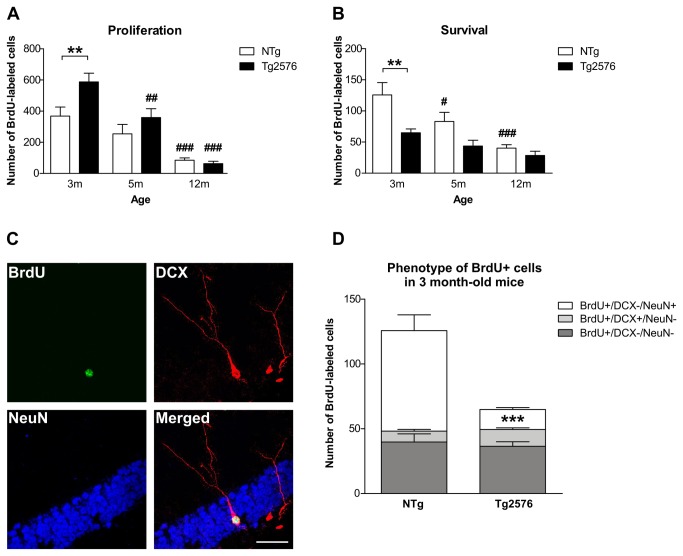
Altered adult hippocampal neurogenesis in 3 month-old Tg2576 mice.(A) New cell proliferation was measured in the dentate gyrus of NTg and Tg2576 mice at different ages (n=8-11 mice/group). Mice from both genotypes exhibit overall decreased numbers of BrdU-labeled (BrdU+) cells in the dentate gyrus along aging, reflecting age-related reduction in cell proliferation. At 3 months, Tg2576 display enhanced proliferative activity compared to age-matched NTg mice. (B) BrdU was injected in 3 month-old mice and numbers of surviving BrdU+ cells were evaluated 30 days after (n=7-9 mice/group). These numbers decreased with age in both genotypes. Moreover, the number surviving BrdU+ cell was drastically reduced in Tg2576 mice injected at 3 months of age compared to age-matched NTg. (C) Confocal analysis was used to score the co-expression of doublecortin (DCX, red) and NeuN (blue) in 30 day-old BrdU+ cells (green) NTg and Tg2576 mice injected at 3 months of age (n=7-9 mice/group). The merged image depicts a BrdU+/DCX+/NeuN- immature neuron. (D) Distribution of BrdU+ cells among cell phenotypes, for both genotypes. Compared to NTg, a significantly smaller number of BrdU+ cells co-labeled with the neuronal marker NeuN in Tg2576 mice. Quantitative data represent mean ± SEM in A, B and D. Data were analyzed by two-way ANOVA with Bonferroni post-hoc: #p<0.05; ##p<0.01; ###p<0.001 age effect for each genotype; **p<0.01; ***p<0.001 Tg2576 vs age-matched NTg. Scale bar C=40µm.